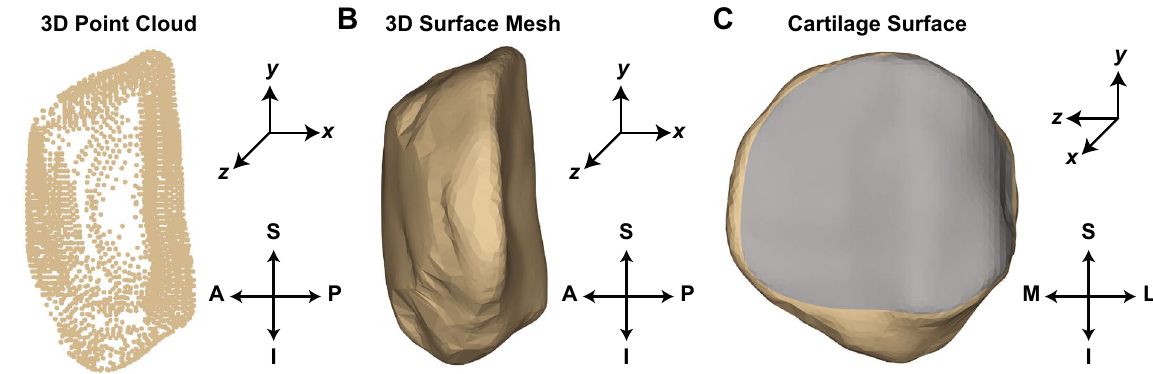
Figure 5. ( A ) Lateral view of a 3D point cloud model generated from semi-automatic segmentations of a human patella. ( B ) Lateral view of a 3D surface mesh generated from the 3D point cloud in ( A ). ( C ) Posterior view of the 3D surface mesh in ( B ). The gray region depicts the area in which cartilage is located. A anterior, P posterior, S superior, I inferior, M medial, L